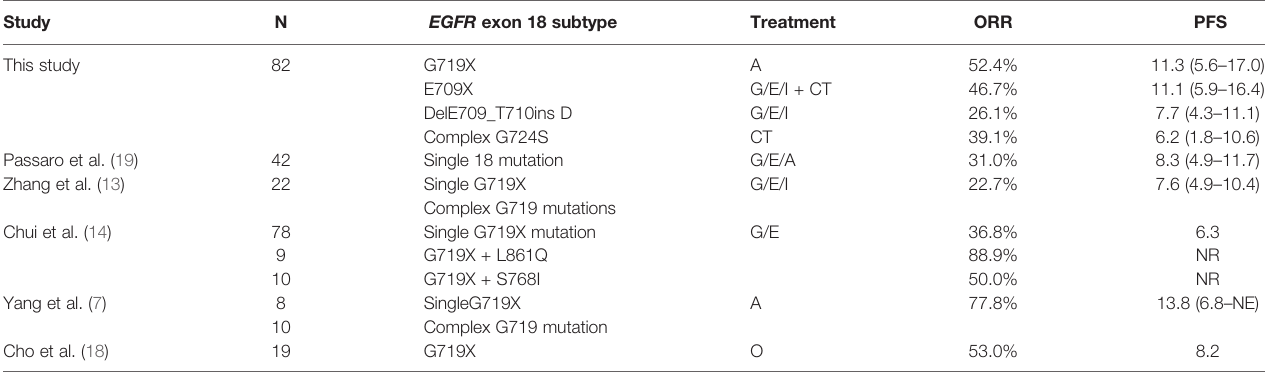
TABLE 3 | Comparisons of different treatments for EGFR exon 18 mutations from various studies. Study N